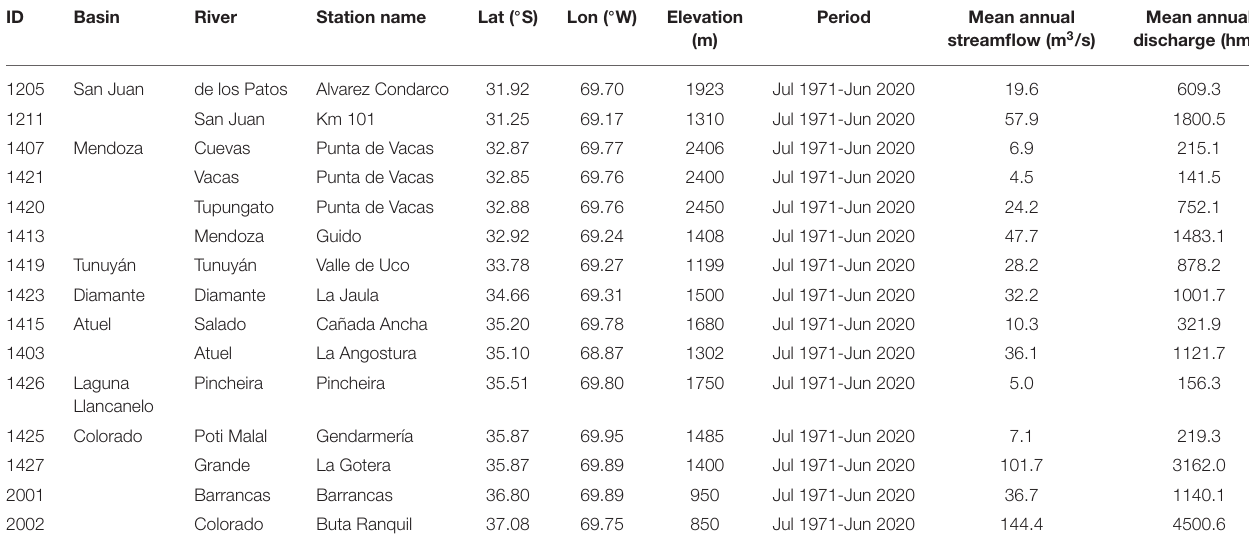
TABLE 1 | Main characteristics of the streamflow stations used in this study. ID